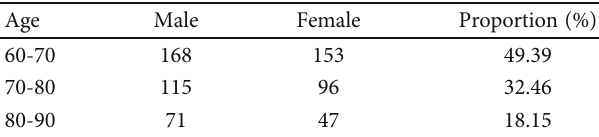
Table 1: Age and gender distribution of